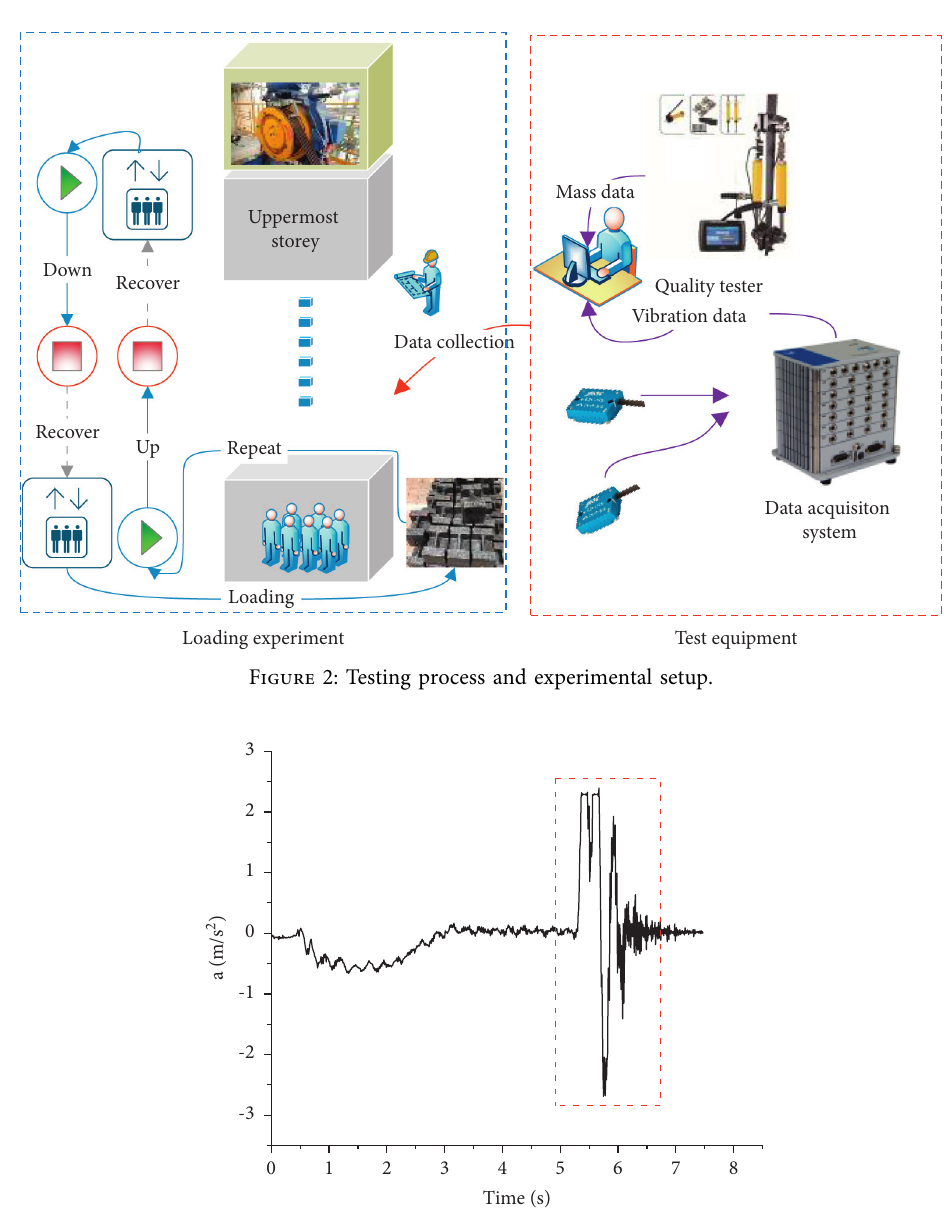
Figure 3: Selection of the emergency stop Table 1 indicates that the experimental emergency stop points are located at the lower part of the elevator’s stroke.